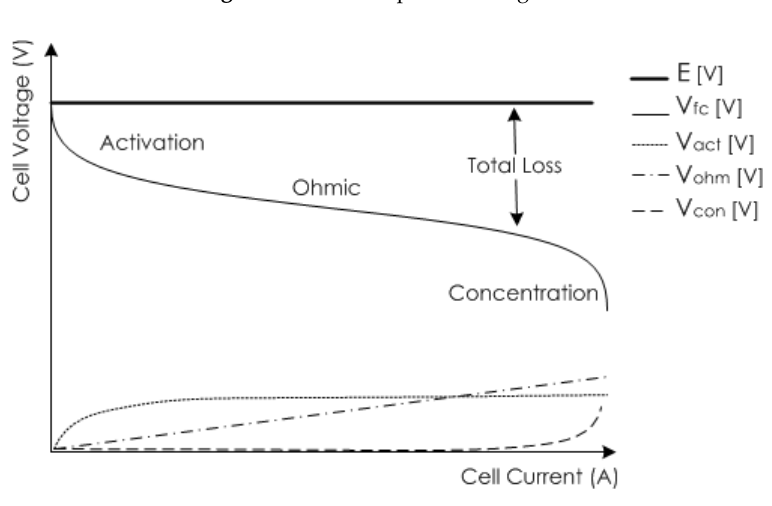
Figure 1. Fuel cell operation diagram.